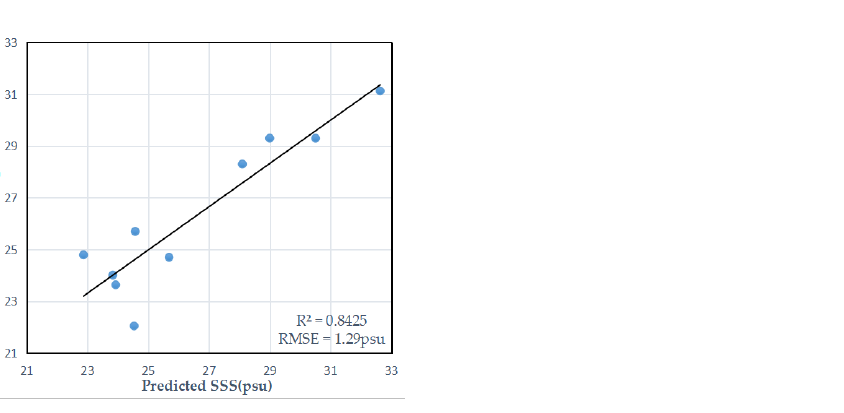
Figure 8. Accuracy evaluation of inversion SSS by empirical model for the near shore sea waters.